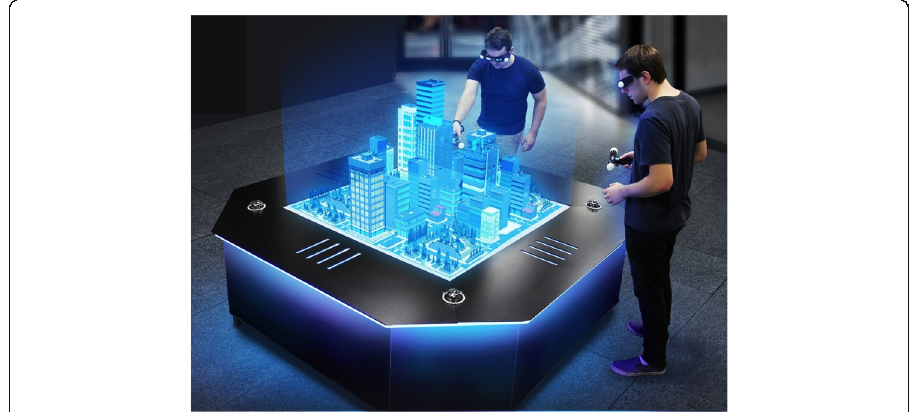
Fig. 11 Hologram technology (Samsung White Paper,